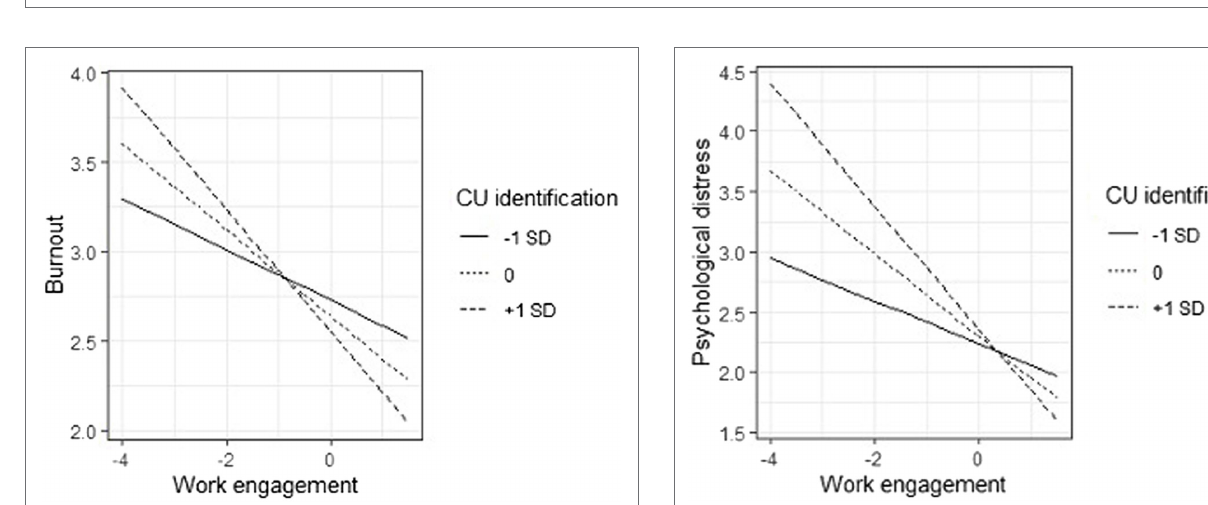
FIGURE 2 | The tested model (standardized betas are reported). Solid lines represent direct and mediational effects. Dashed lines represent the moderation effects of CU identification on relationship of Work engagement and negative outcomes (Burnout and Psychological distress); interaction betas are reported in